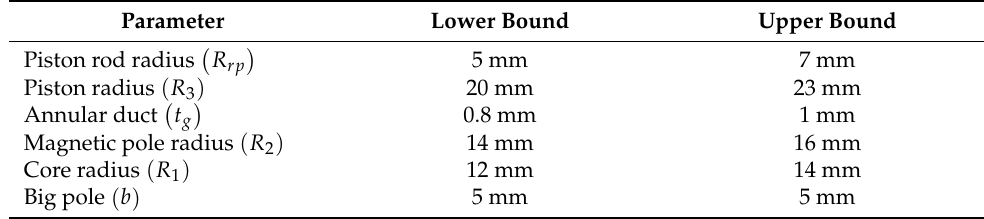
Figure 6. Flowchart of genetic algorithm used for optimization. Table 2. Lower and upper bounds of design